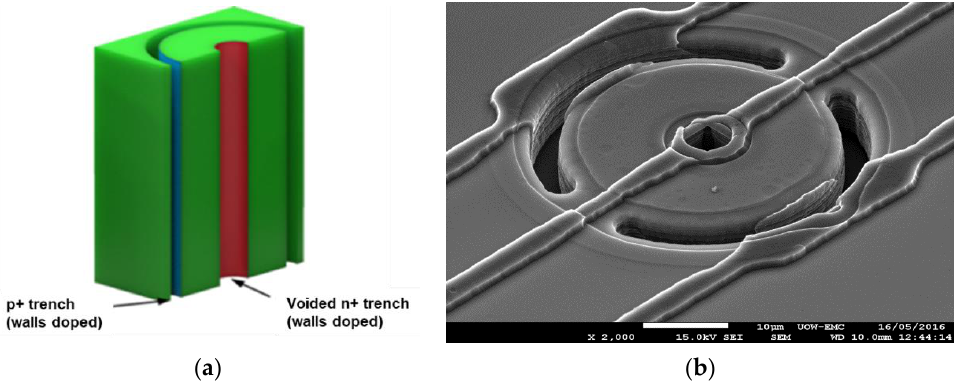
Figure 3. ( a ) Simplified schematic of a trenched-3D microdosimeter with a voided p + trench and a voided n + trench and ( b ) SEM image of the trenched-3D design of a single 3D Mushroom microdosimeter SV [21].